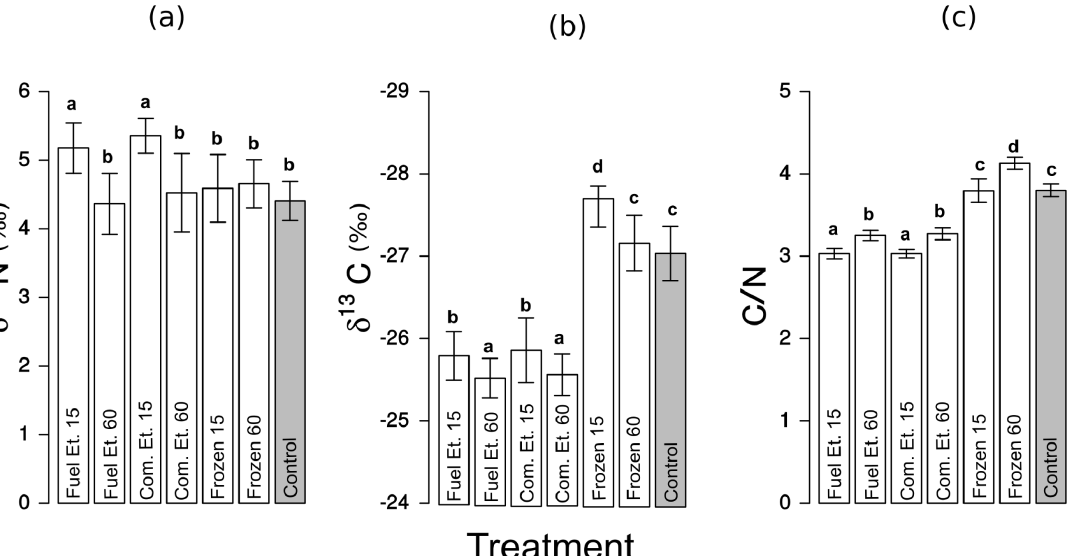
Fig 1. Carbon and nitrogen stable isotope values, and C/N atomic values for Phoremia sp. Mean ± standard deviation of (a) δ 15 N, (b) δ 13 C, and (c) C/N atomic values from the following treatments: Fuel Et. 15 — preserved in fuel ethanol for 15 days; Fuel Et. 60 — preserved in fuel ethanol for 60 days; Com. Et. 15 — preserved in 92.8% commercial ethanol for 15 days; Com. Et. 60 — preserved in 92.8% commercial ethanol for 60 days; Frozen 15 — frozen for 15 days; Frozen 60 — frozen for 60 days; Control — freshly processed material (highlighted in gray). Different letters indicate significant differences between treatment groups (P <